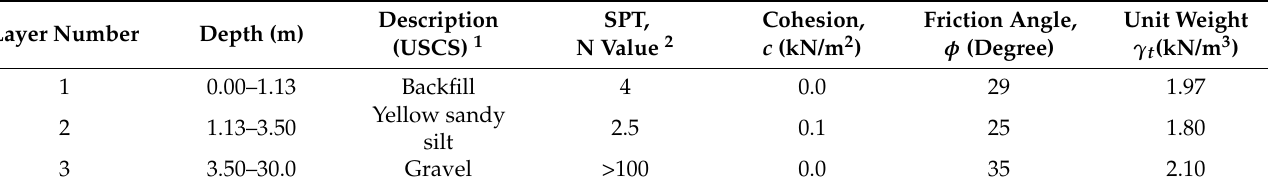
Figure 5. Surface loading of the design. Table 1. Physical properties of each layer for the numerical computation.